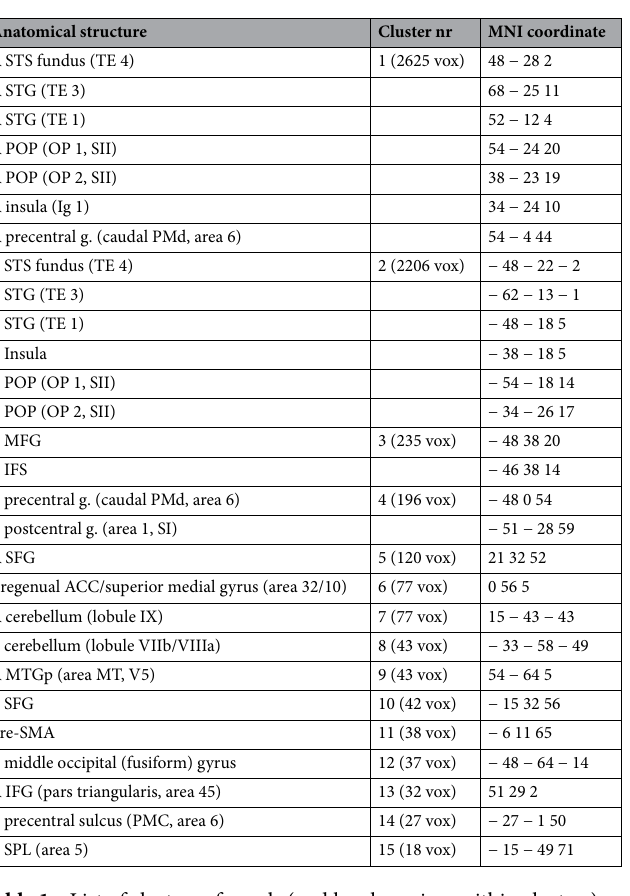
posterior insular cortex: cytoarchitectonically, the inferior boundary of SII is the retro-insular cortex, and the inferior boundary of SII (which is located mainly in the parietal operculum ) transgresses the circular sulcus into the posterior insula (see inset in Fig. 2a) 50 . Thus, the macroanatomical boundary between insula and POP (the circular sulcus) is not the cytoarchitectonic boundary between insular cortex and SII, and the posterior insula is not equivalent to the posterior insular cortex (because part of SII is located in the posterior insula).